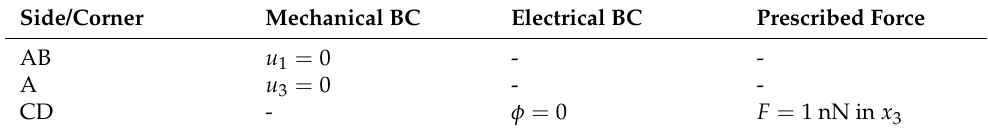
Figure 4. Cantilever beam model with transverse load F on its end. Table 1. Boundary conditions and loads for the cantilever beam